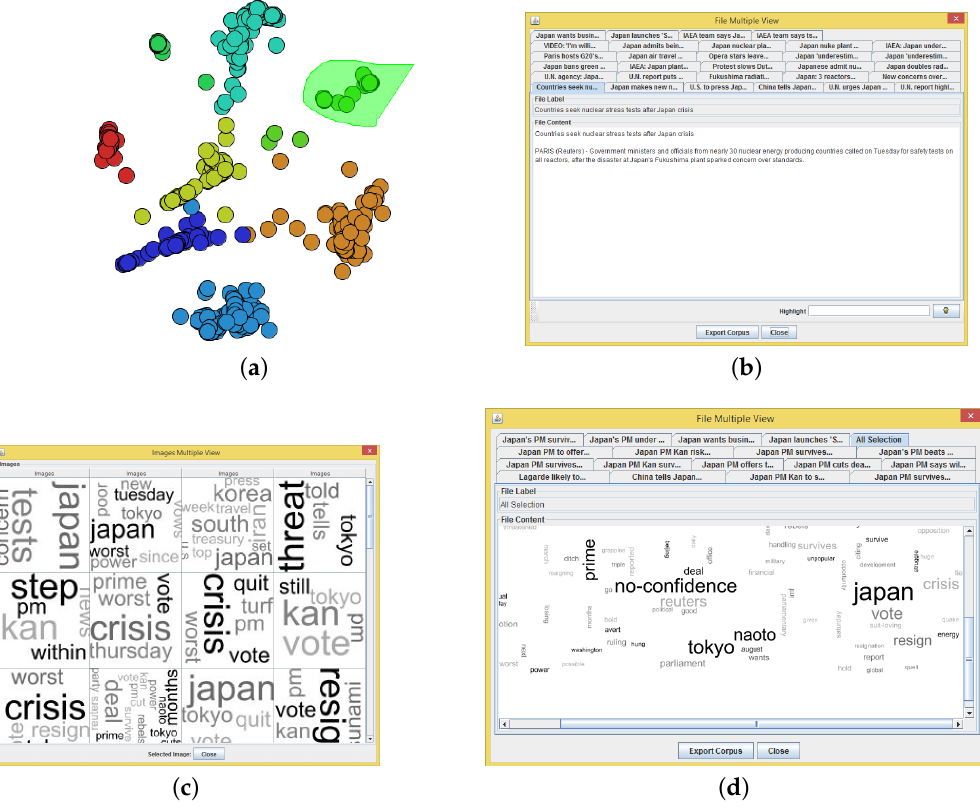
Figure 5. Interaction tools: ( a ) selection of a group o documents; ( b ) the content of each document is shown in a separated view; ( c ) the tag cloud of each document is shown in a separated view; ( d ) a tag cloud build from the selection (all selected documents) is shown in a separated